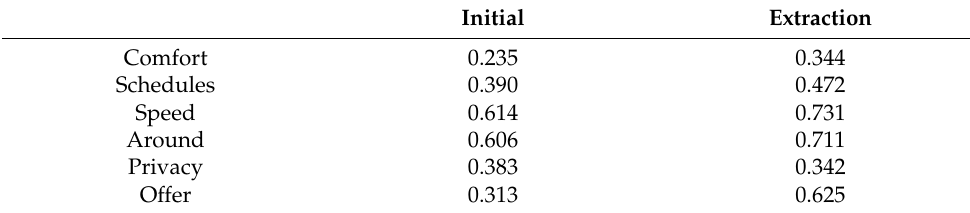
Table 4. Communalities obtained using the extraction method of maximum likelihood. Initial Extraction Comfort 0.235 0.344 Schedules